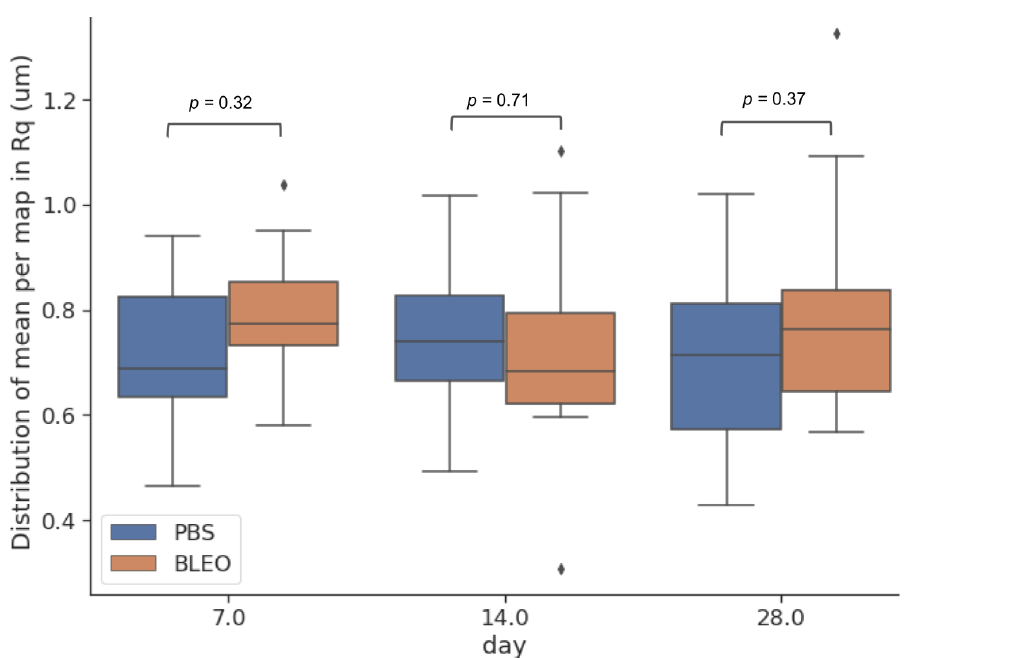
Figure 3. Surface roughness R q calculated from local height variations of the high-resolution maps. The centre line in the boxplots represents the median value, the top and bottom limits of the box represent Q1 and Q3 of the data. Whiskers represent minimum and maximum value of the data, the diamonds represent the outliers and are data points outside 1.5 times the interquartile range. ( n = 9 for control and n = 21 for fibrotic, corresponding to 3 maps per